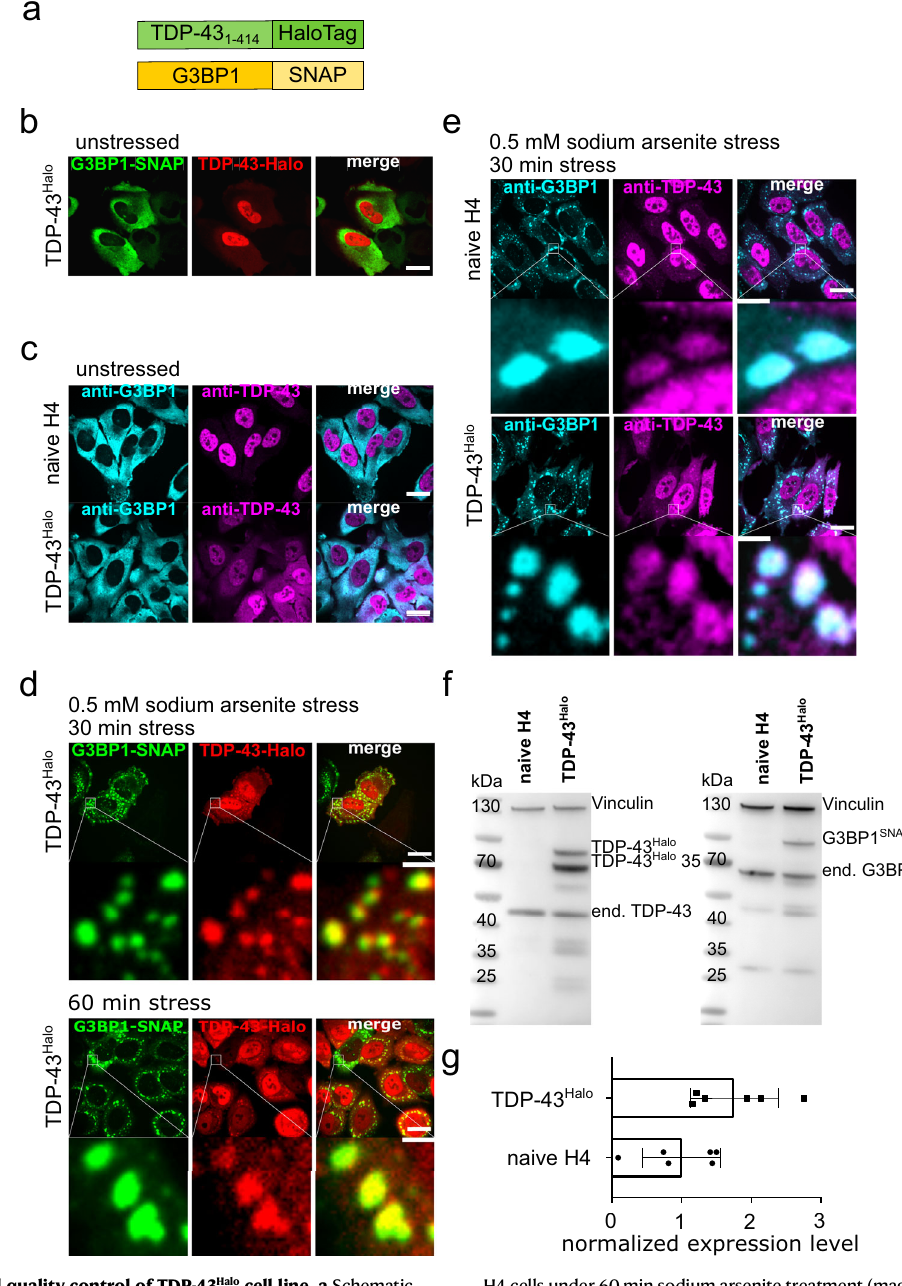
H4cells under60minsodiumarsenite treatment(magenta:anti-TDP-43-Alexa647, cyan: anti-G3BP1-Alexa532, scale bar 20 µ m and 2 µ m). f Western Blot overview of the TDP-43 Halo cell line and naïve H4 cells stained with anti-vinculin, anti-TDP-43 or anti-G3BP1antibodiesshowingproperexpressionofthetransgenicconstructs.The experimentwasperformedintriplicates. g Quanti fi cationoftheoverexpressionfor the TDP-43 Halo cell line compared to endogenous TDP-43 in naïve H4 cells shows a 1.5 – 2x overexpression of TDP-43 Halo , n =5 independent preparations, data are dis- played as the mean+/ − STD. Source data are provided as a Source Data fi